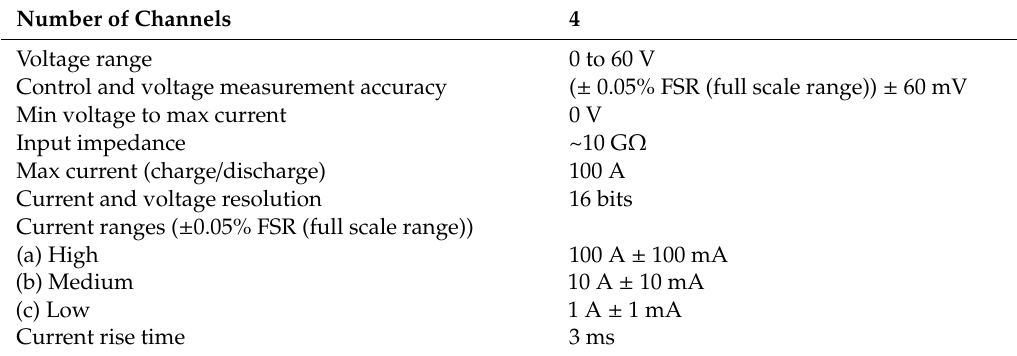
Table 9. Arbin © battery test bench